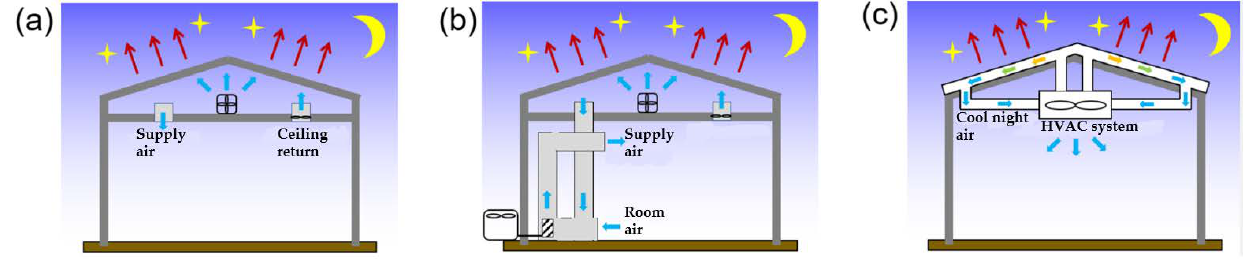
Figure 13. Different air-based system configurations